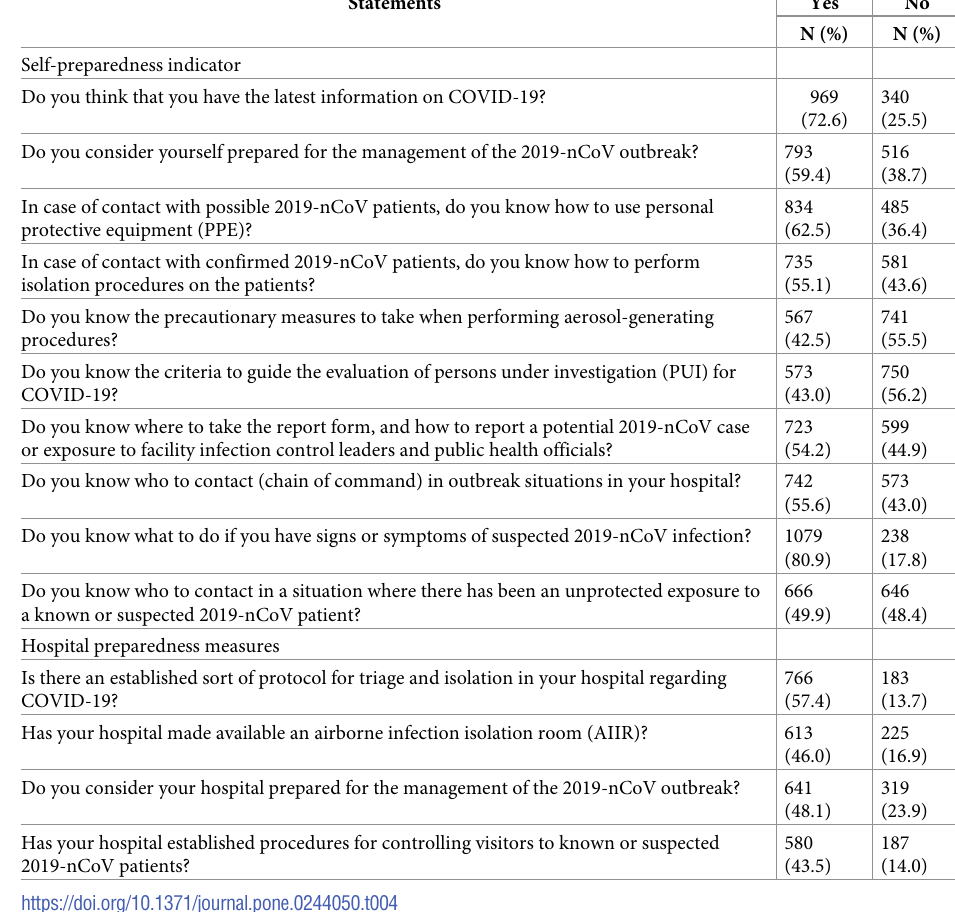
Table 4. Assessment of preparedness of health professionals and the respective hospitals towards the